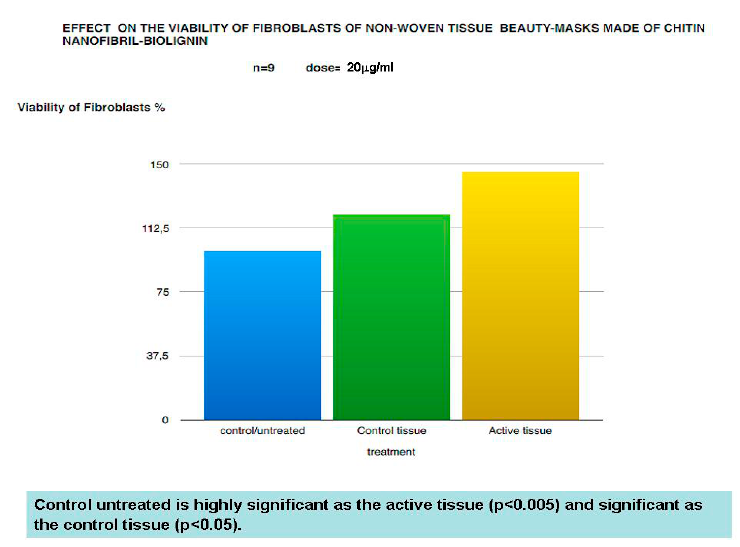
Figure 2. Viability of fibroblasts treated by the mask determined by the MTT method.